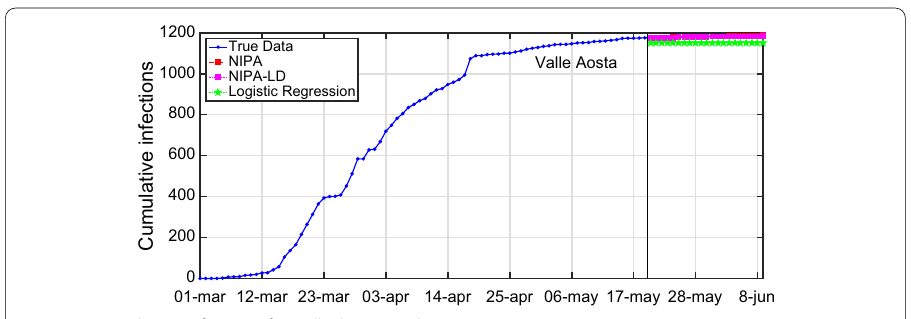
Fig. 13 Cumulative infections for Valle d’Aosta with n neglect =